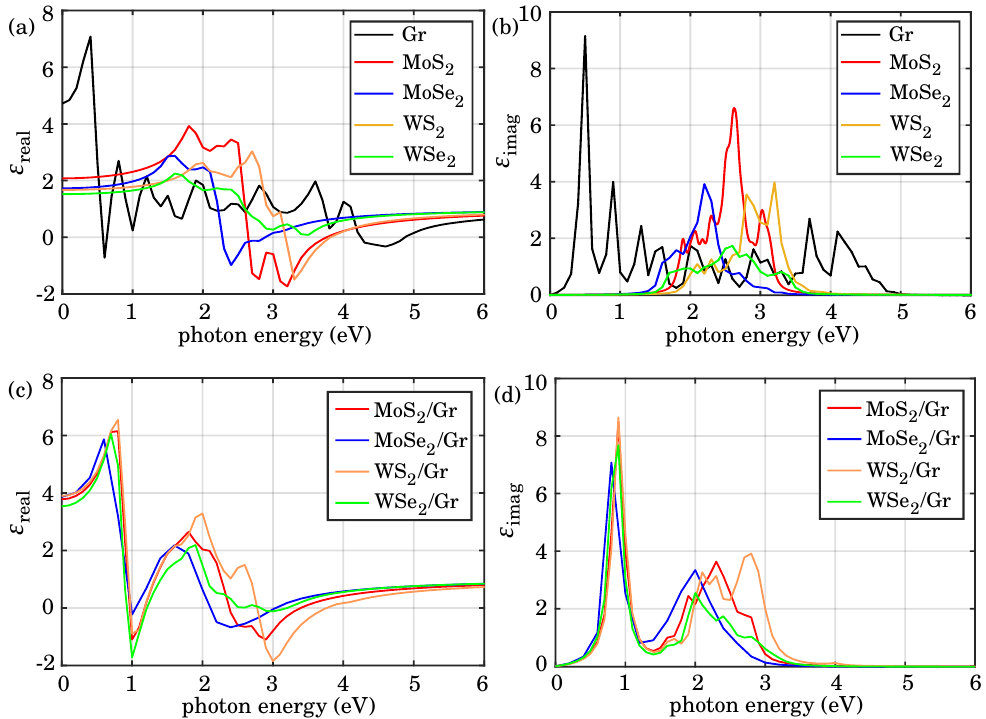
Figure 3. The complex permittivities for MX 2 /Gr heterostructures and MX 2 and Gr monolayers as functions of incident photon energy. ( a , c ) The real part of the permittivity ε real . ( b , d ) The imaginary part of the permittivity ε imag